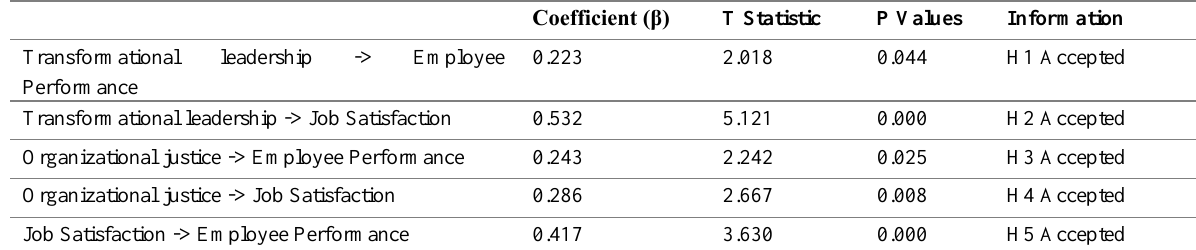
Table 5: Result of Direct Effect Testing